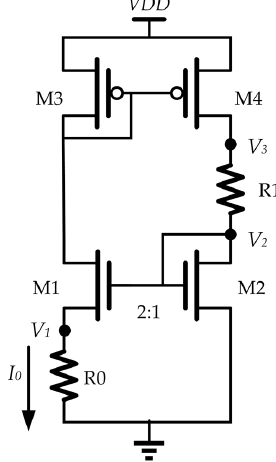
Figure 2. Circuit implementation of the temperature-to-current conversion.